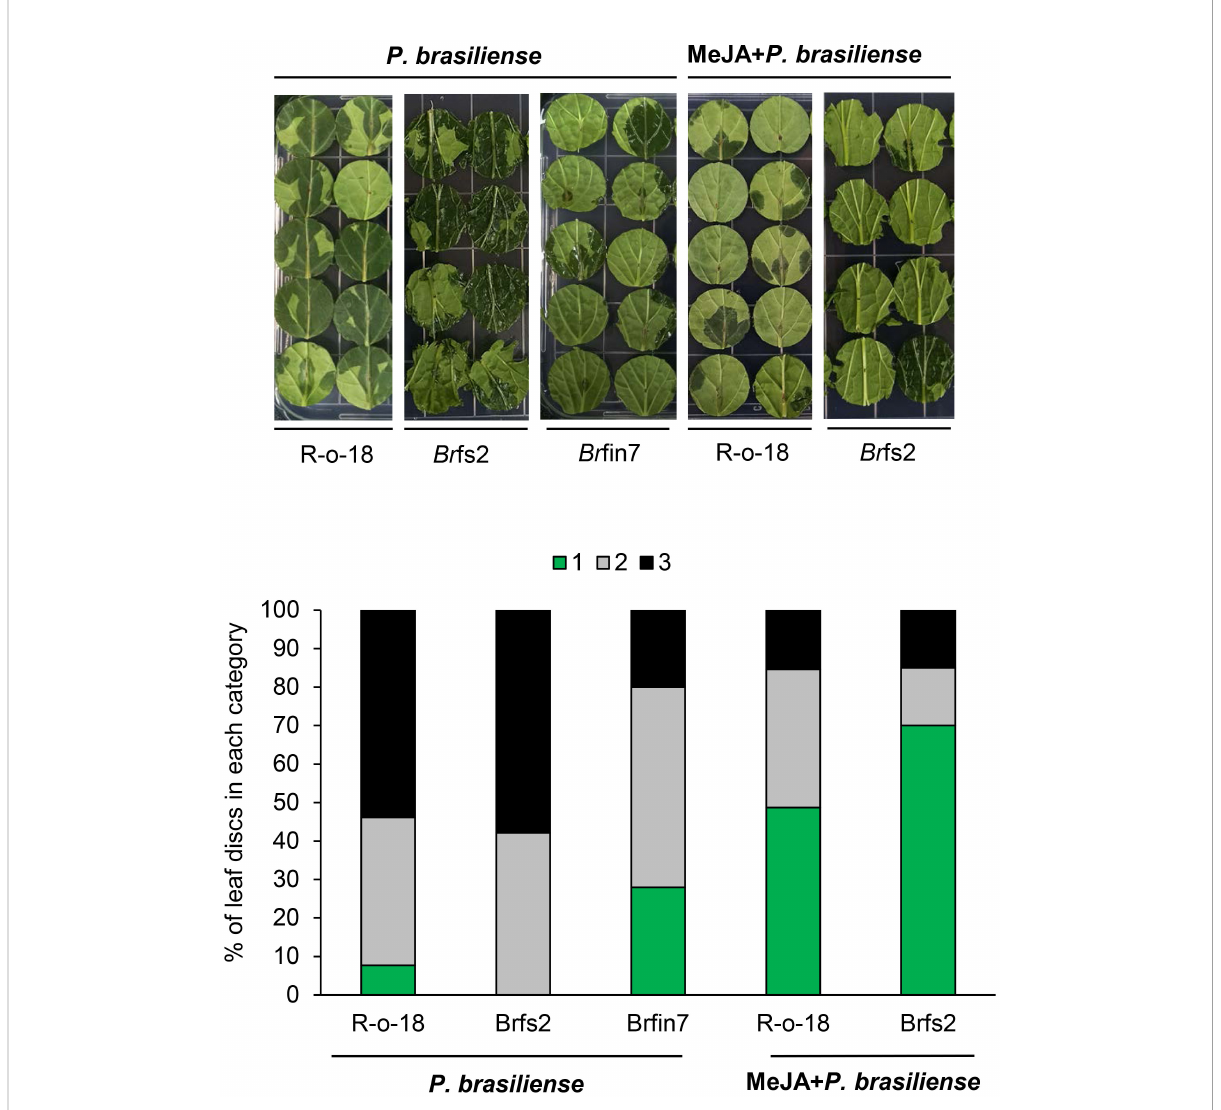
FIGURE 5 Suppressed necrotic symptom development of MeJA-pretreated B. rapa leaves to P. brasiliense . Six-week-old B. rapa plants were pretreated with MeJA (1 mM) or water and inoculated with 5 m l P. brasiliense suspension (1 × 10 8 CFU/mL) after 24 h. Disease development was scored on the basis of the leaf disc lesion area (0% = 1, 1% – 50% = 2, 51% – 100% = 3) at 24 h post-inoculation. The bars represent the percentage of leaves with a speci fi c disease severity score (n ≥ 30). The experiment was repeated twice with similar